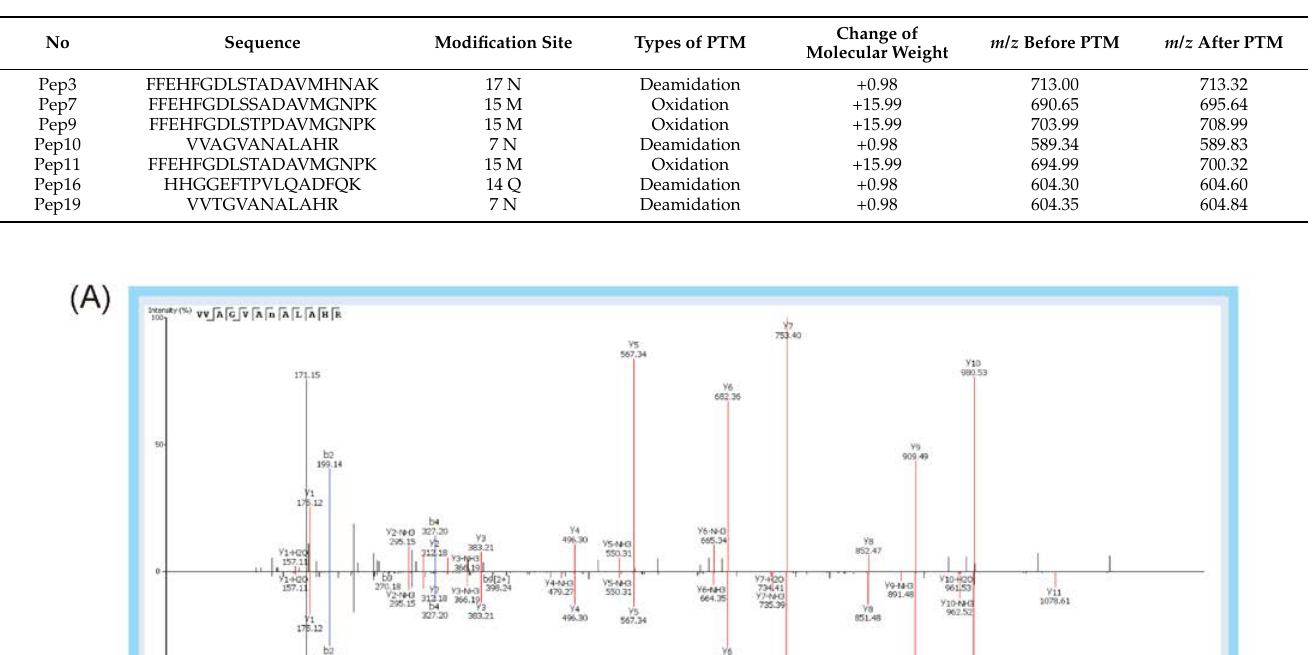
Table 2. Post-translational modifications (PTM) of peptide biomarkers.